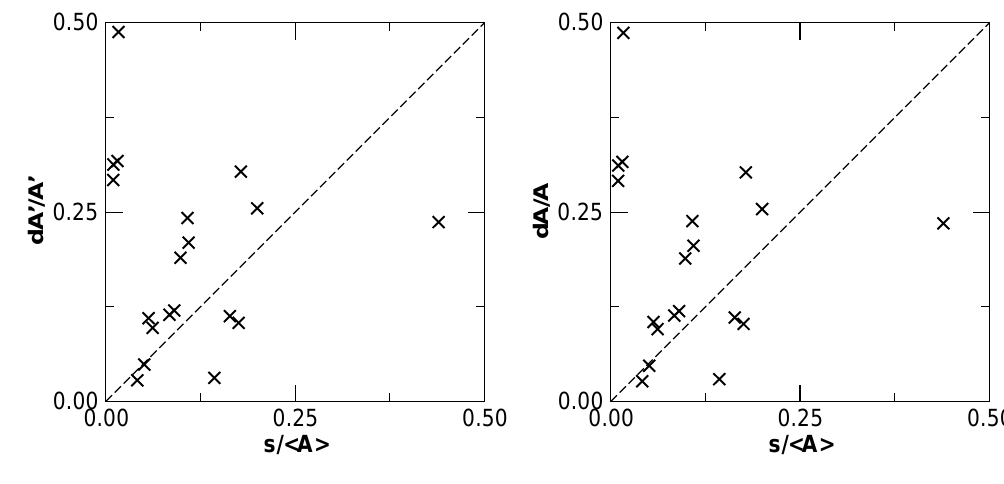
Figure 2. Left panel shows (cid:14)A ′ =A ′ vs s= (cid:22) A and right panel shows (cid:14)A=A vs s= (cid:22) A for 20 intercombination E1 transitions in O IV. Transition rates are taken from [21]. See text for